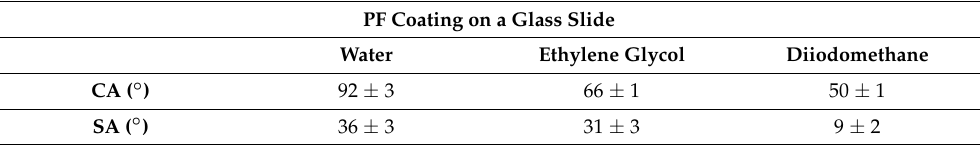
Figure A3. Brightfield microscopy images of 5 µL droplets of water, ethylene glycol and diiodomethane on the soft PDMS surfaces. The red rectangle highlights the three-phase contact line area where the confocal microscopy images were taken in the Z-axis. Table A4. CA and SA of water, ethylene glycol, and diiodomethane on a PF surface.